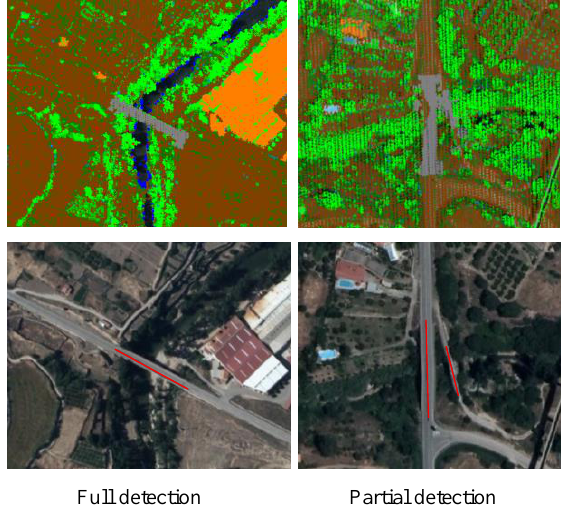
Figure 5 – Examples of bridge detection situations (in grey) Considering the bridge classification results there are some ground under the bridge are classified wrongly. In most of these bridge, so the algorithm is not able of determine which points are elevated.